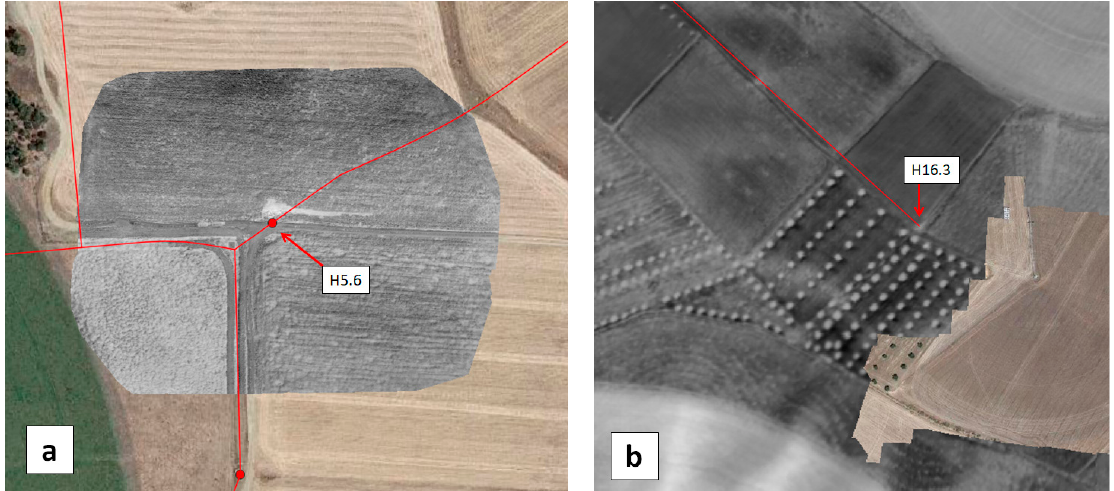
Figure 15. ( a ) WI images obtained with the UAV on 16 May 2019, over the test field containing hydrant H5.6. The WI images are with greyscale (white for wet and black for dry), the water network is overlaid in red and Goggle Earth data (in color) fill the surrounding area. ( b ) Excerpt of the WI map obtained on 16 May 2019 with the MAV in the vicinity of a small leak at hydrant H16.3 that was previously detected by the acoustic method.